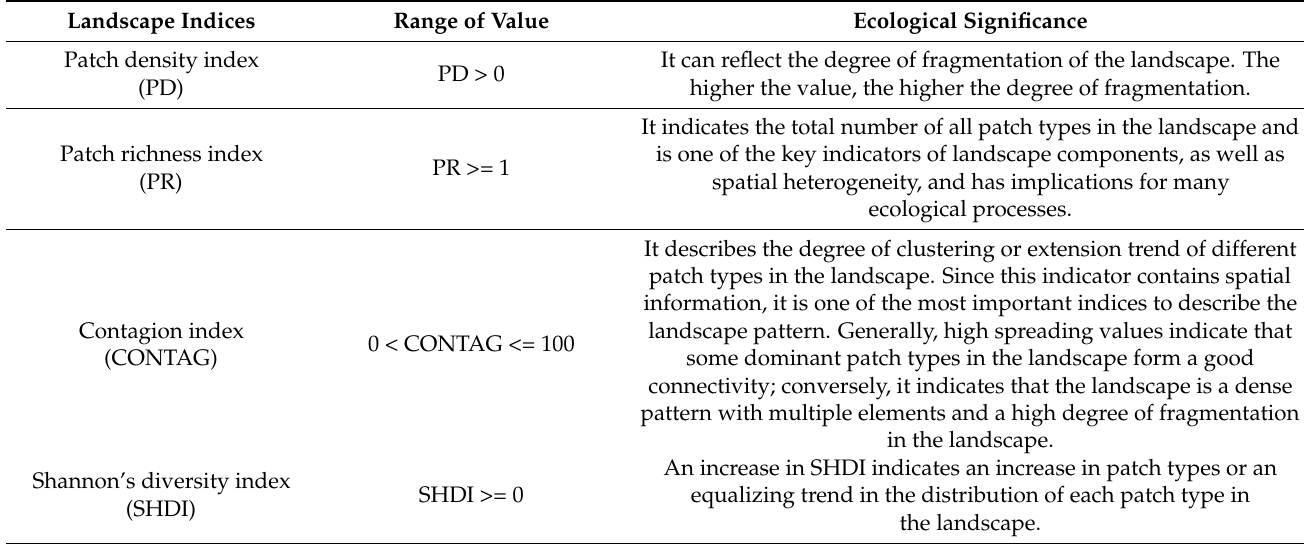
Table 2. Selected landscape indices and their ecological